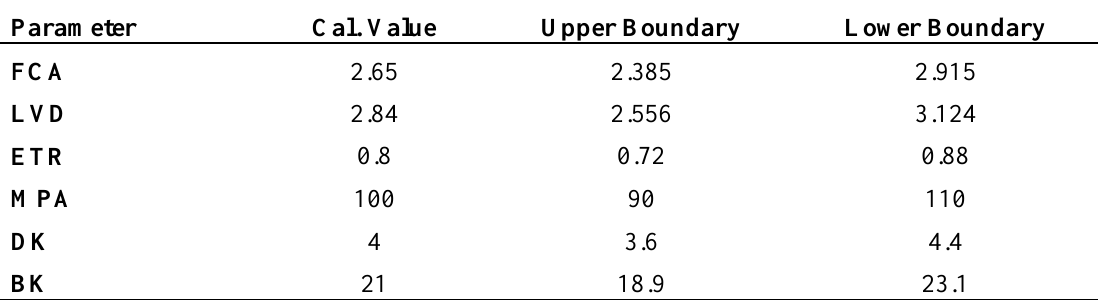
Table 2. Model parameters from the calibrated daily model along with parameter boundaries for sensitivity